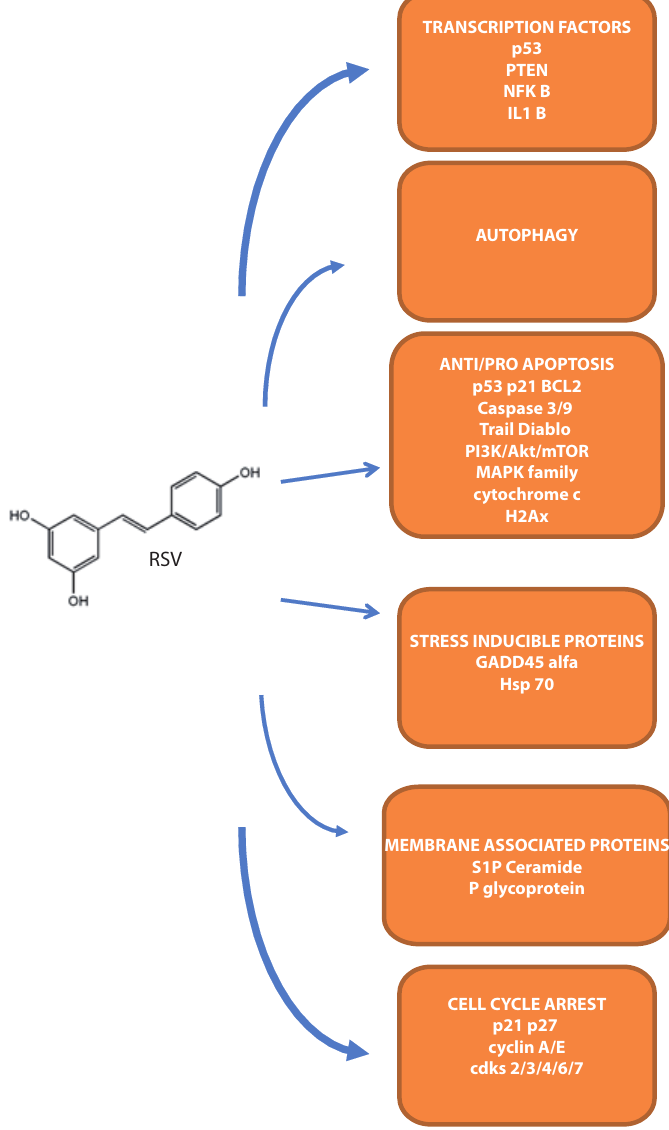
Figure 2. Overview of the main molecular targets demonstrated in leukemia